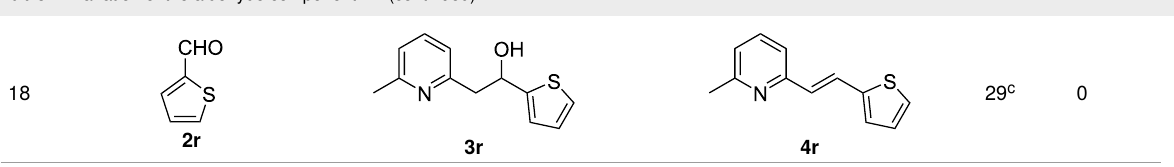
Table 2: Variation of the aldehyde component 2 . a (continued)